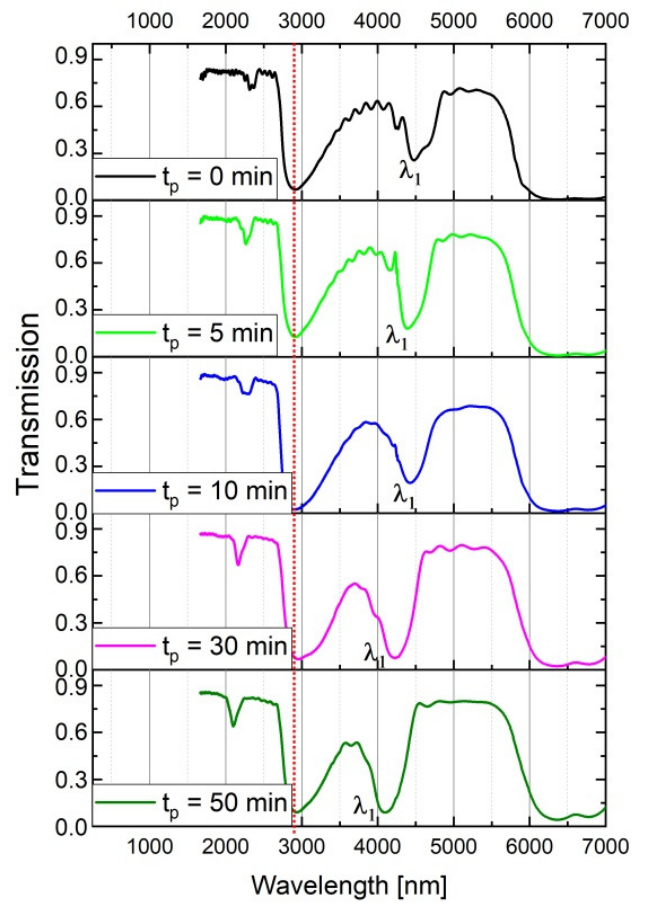
Figure 3. Transmission spectra of the PAA_600-60 DBR for different t p . Four PAA-based DBRs were produced under the time-controlled mode, where the duration of U H and U L pulses was varying while maintaining the t H + t L = 660 s. In Figure 4, the U(t) and i a (t) curves for the first three cycles and the corresponding transmission spectra of the PAAt L –t H samples (after t p = 60 min) are shown. First of all, it can be noted that the λ 1 peaks in the MIR spectral range (>3000 nm) are very symmetrical and intensive (transmittance at the center of the λ 1 is close to zero). Moreover, a simultaneous increase of the t L and decrease of the t H by 40 s makes the λ 1 band to shift from ca. 5000 nm to 4000